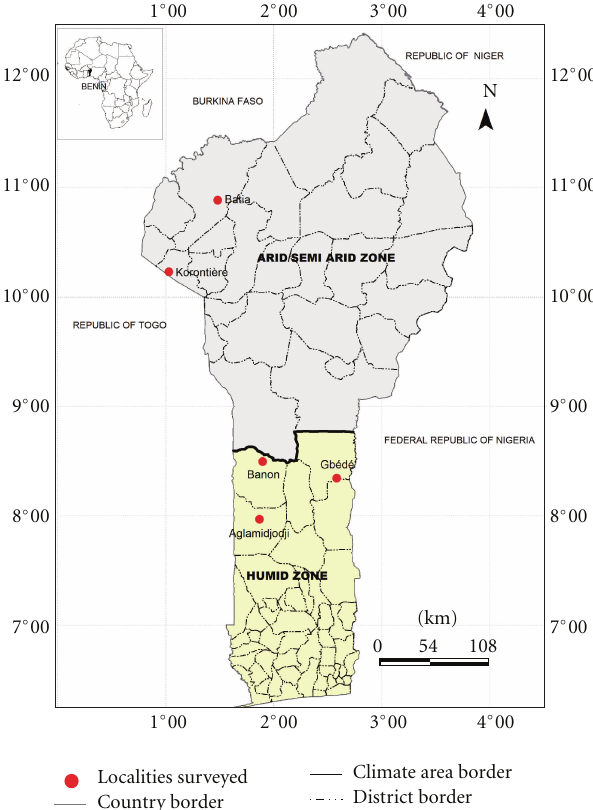
Figure 1: Benin map showing the location of the surveyed